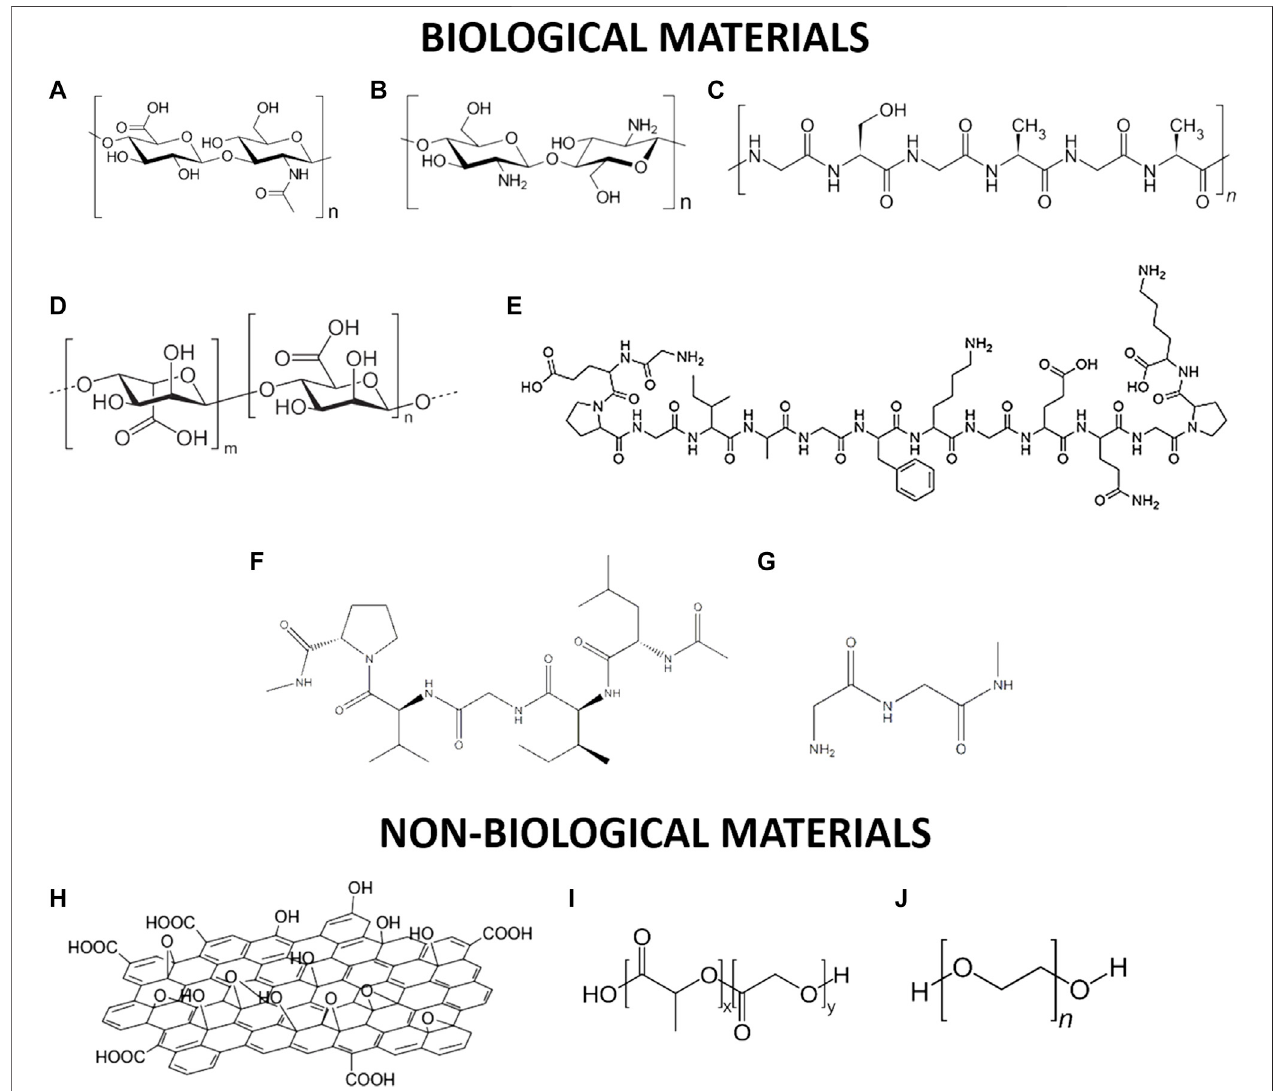
FIGURE 1 | Schematic representation of selected biological and non-biological materials used for tissue regeneration: (A) alginate; (B) chitosan; (C) silk; (D) hyaluronic acid; (E) type II-collagen; (F) elastin; (G) fi brin; (H) graphene oxide; (I) poly(Lactide-co-Glycolide) (J) poly(ethylene glycol).